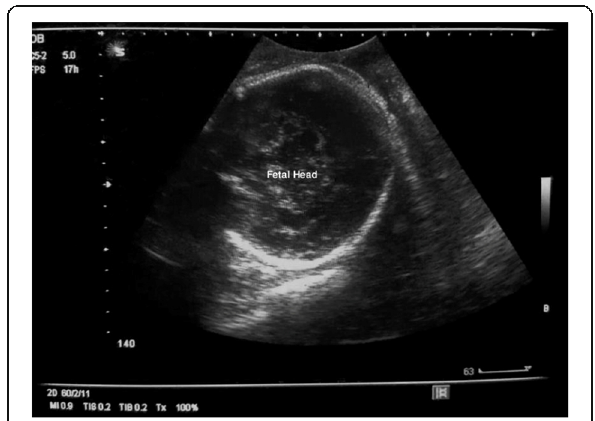
Fig. 2 Fully dilated cervix shown by TPUS. TPUS showing no cervical tissue to be measured denoting full cervical dilatation